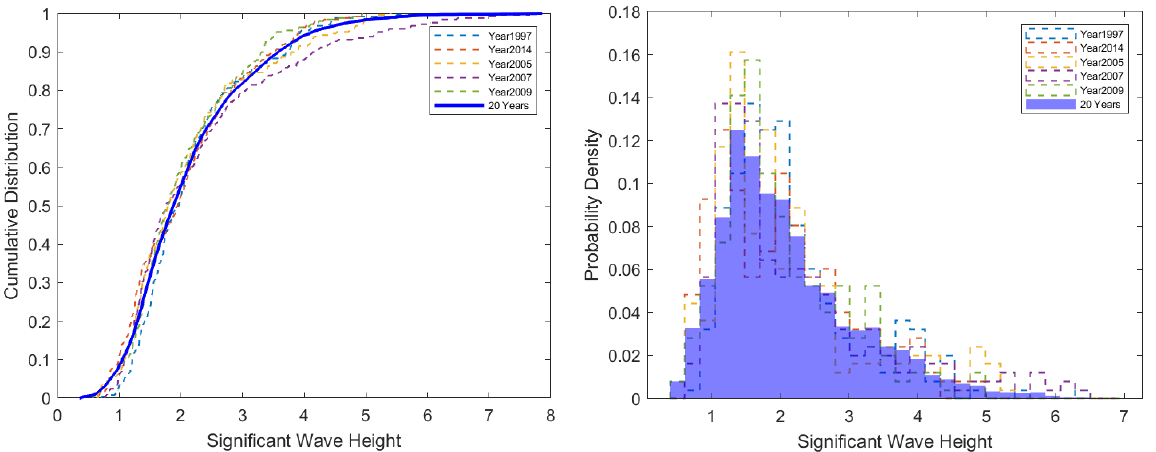
Figure 3. The cumulative distributions ( left ) and probability densities ( right ) of significant wave height in March from five candidate months identified by the component of extreme condition encapsulations.